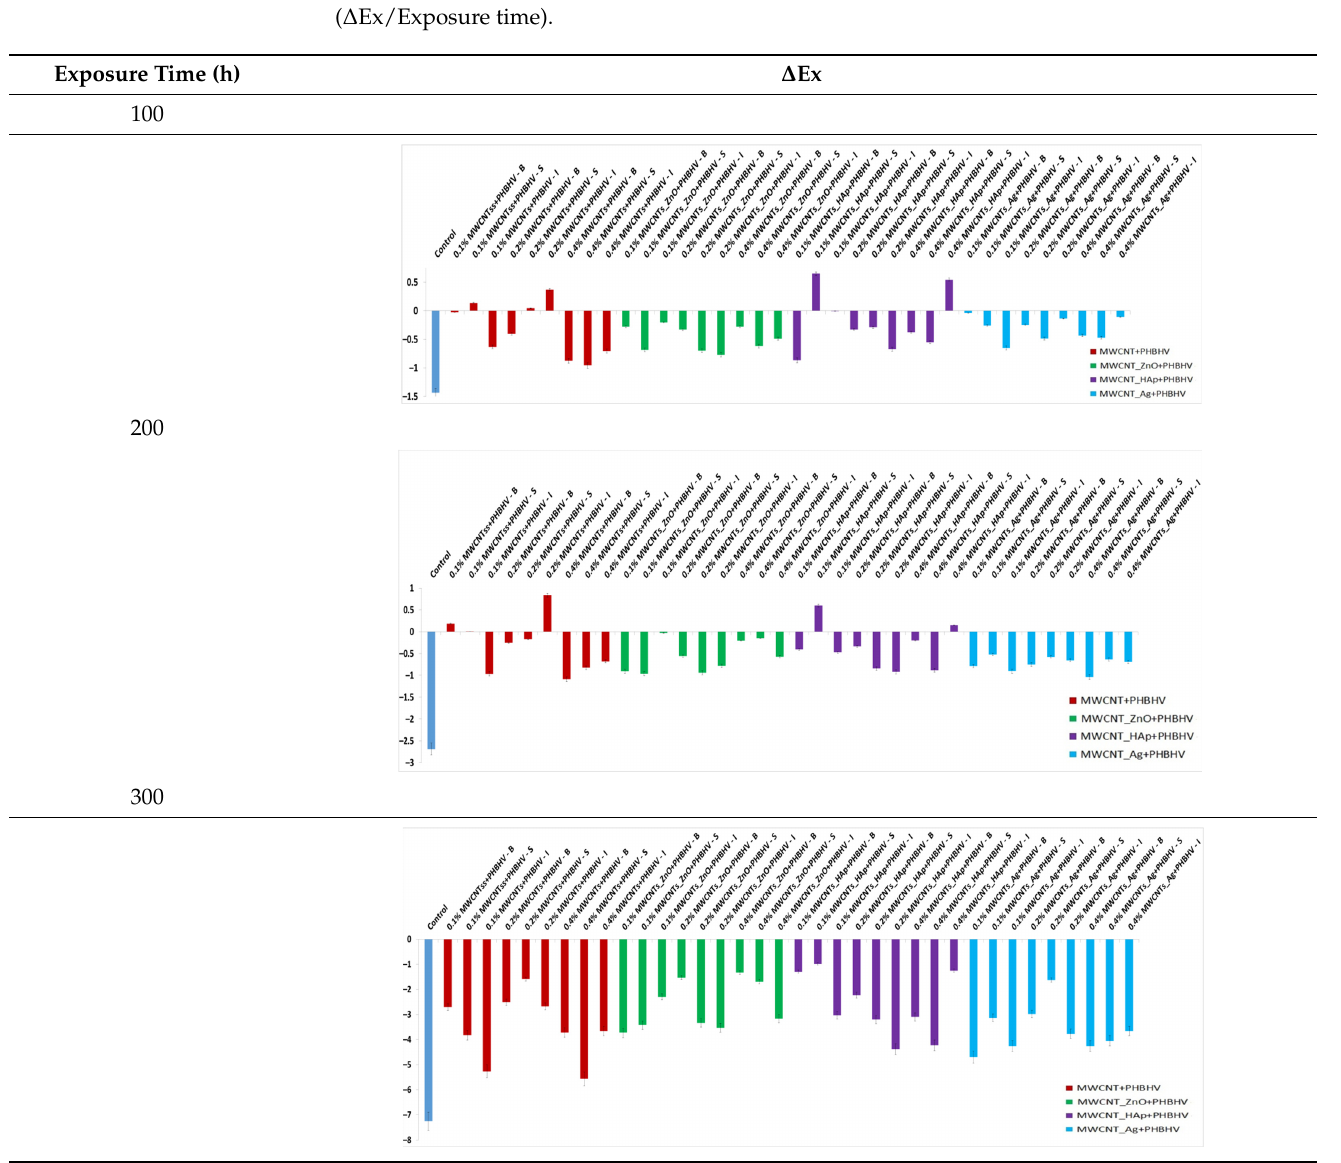
Table 5. Total color difference calculated after artificial aging test by UV radiation exposure ( ∆ Ex/Exposure time).